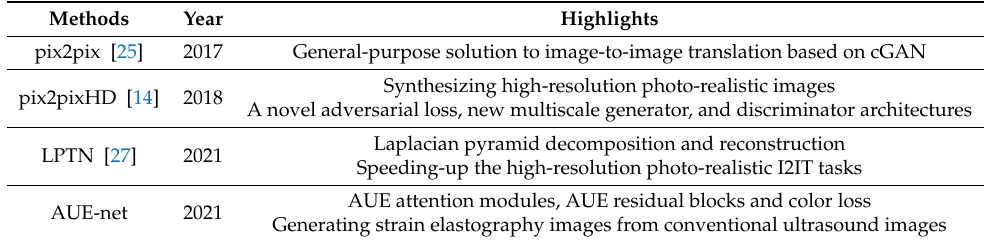
Table 2. Comparison among our method and state-of-the-art